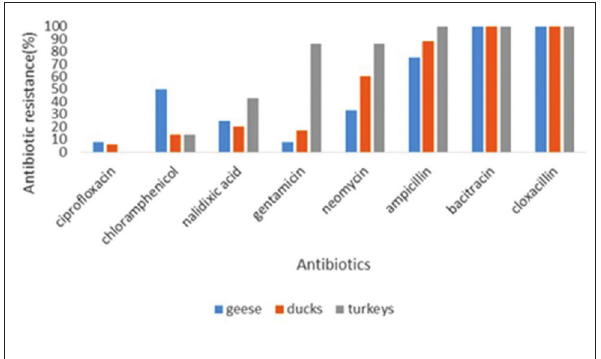
Figure-1: Antibiogram of avian fecal Escherichia coli from turkeys, geese, and